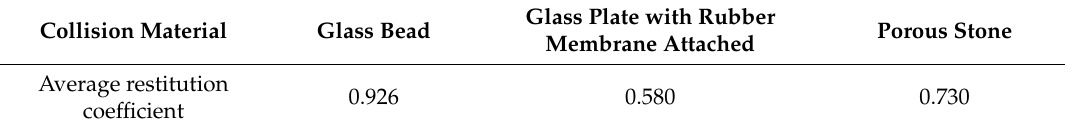
Table 3. Parameters of restitution coe ffi cient between glass beads and various